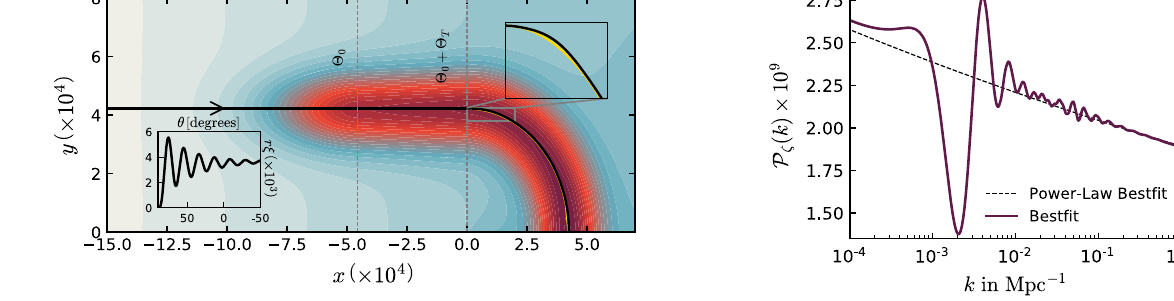
Fig. 2 The PPS of the bestfit model with the effective parameters: V inf = 5 . 45 × 10 − 14 , C (cid:4) = 0 . 0189, C σ = 3 . 15 × 10 − 8 , C σ /(cid:4) 2 0 . 495, m σ / H = 18 . 5, ξσ f = 0 . 0580, N T = 1 . 17, N 0 = 14 . 38. These gives (cid:10) P ζ | dip / P ζ 0 (cid:3) 0 . 28 and (cid:10) P ζ | clock / P ζ 0 (cid:3) 0 . 038. In this model, k 0 ≈ 6 . 66 × 10 − 4 Mpc − 1 , corresponding to the bottom of the dip located at k dip ≈ 2 × 10 − 3 Mpc − 1 or equivalently (cid:2) dip ∼ 20; and k r ≈ 4 . 38 × 10 − 2 Mpc − 1 or (cid:2) clock ∼